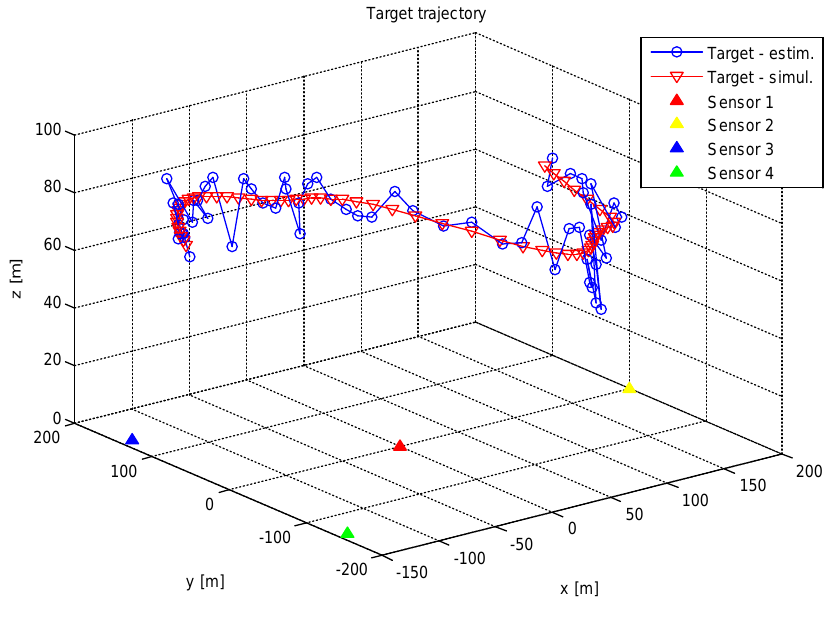
Figure 4. The target trajectories.